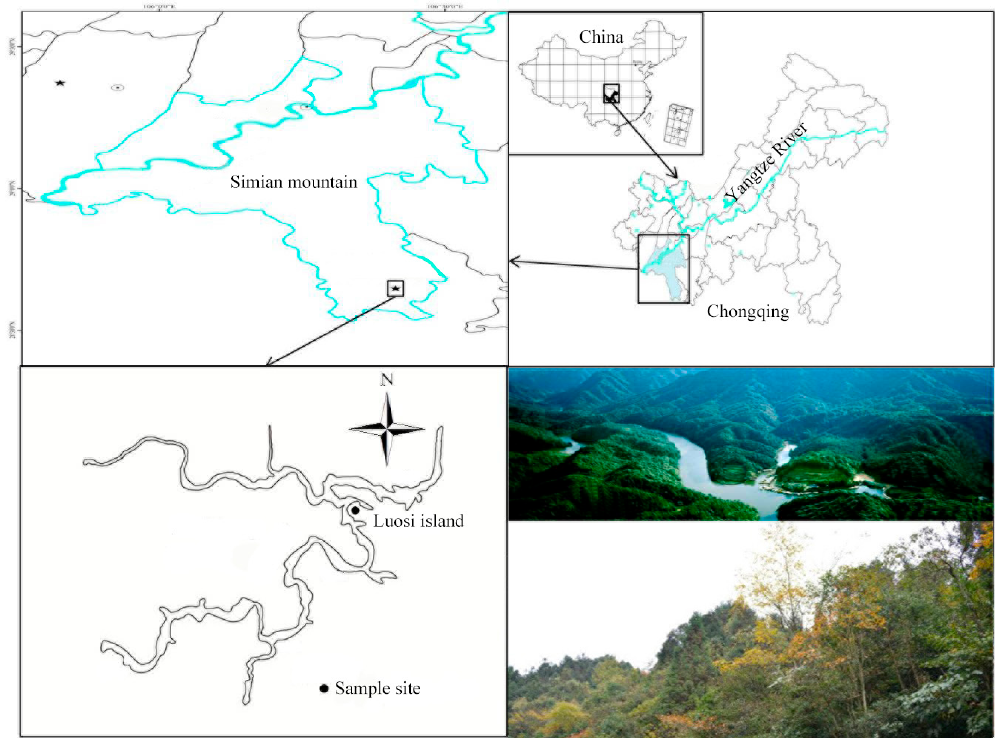
Figure 1. Schematic diagram of the study site, Mt. Simian in Chongqing, China.